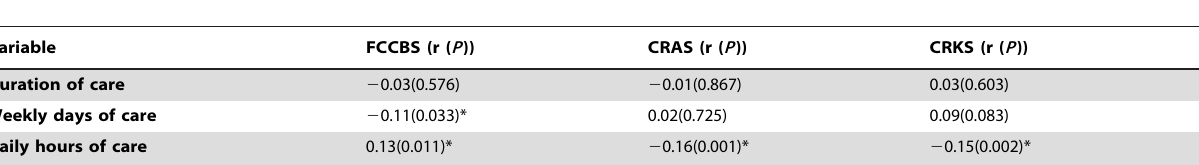
Table 2. Correlation between CRKS, FCCBS, CRAS, and continuous